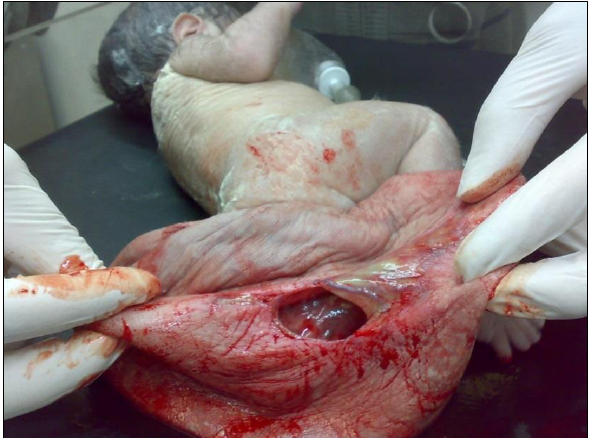
Figure 1: Showing a huge ruptured sacrococcygeal teratoma with massive hemorrhage Sacrococcygeal teratoma (SCT) is derived from the coccyx base with an incidence of 1 in